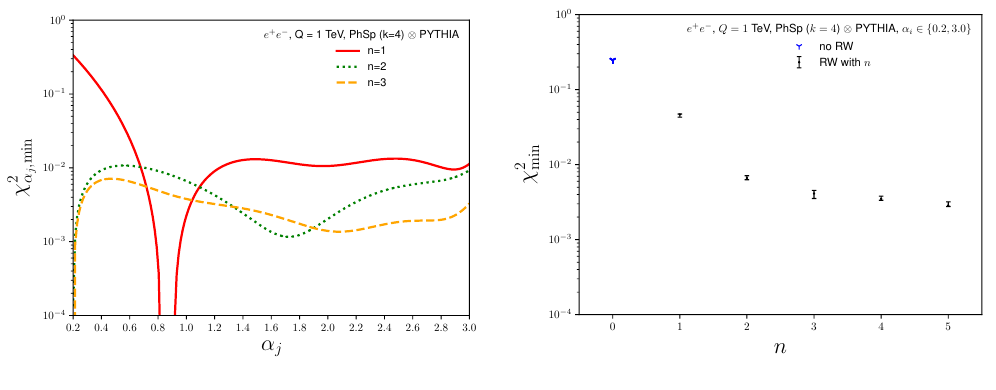
Figure 8 . Same as (cid:12)gure 7 but using Pythia .